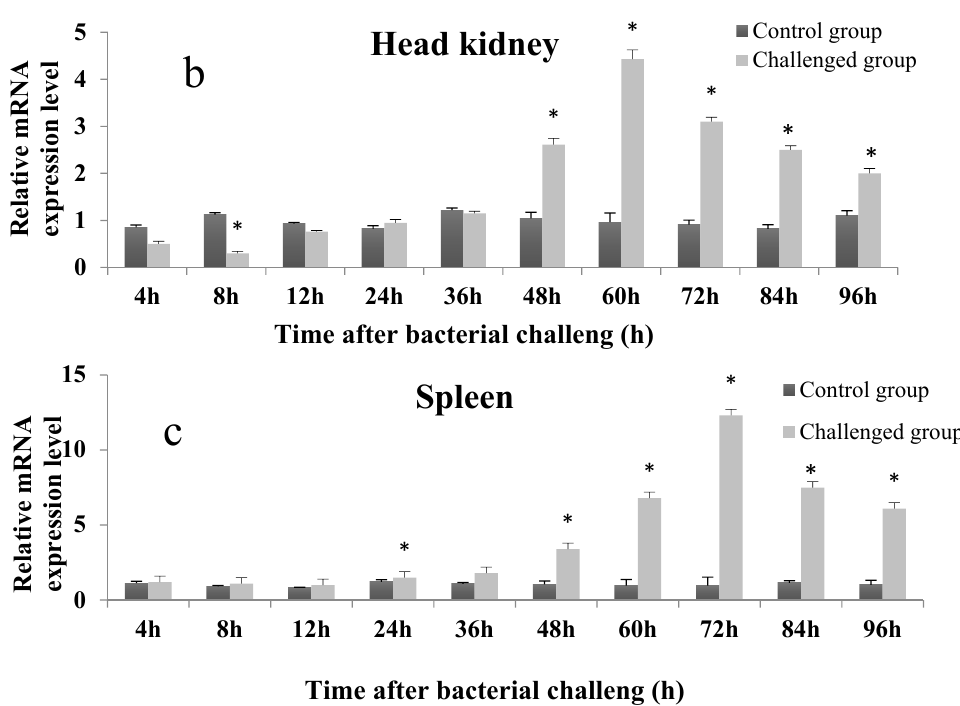
Figure 6. Temporal expression of On-mIgD in thymus ( a ); head kidney; ( b ) and spleen ( c ) of O. niloticus after S. agalactiae challenge were measured by fluorescent real-time RT-PCR. Significant difference was indicated by asterisks, *: 0.01 < p < 0.05.